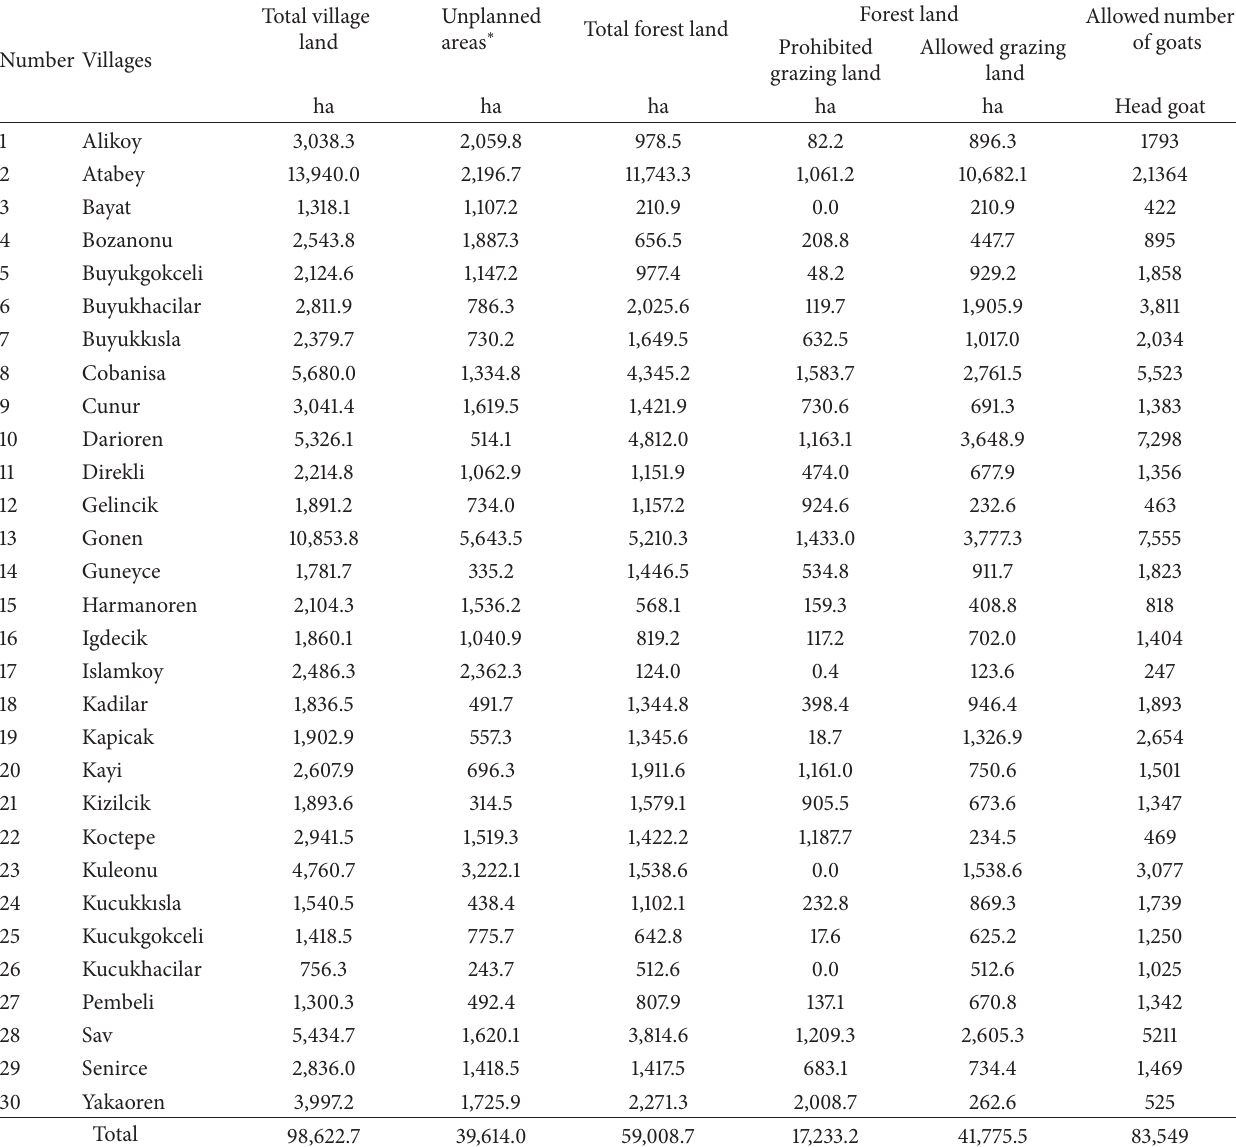
Table 1: Land inventory and prohibited-allowed forest lands of grazing management plan.